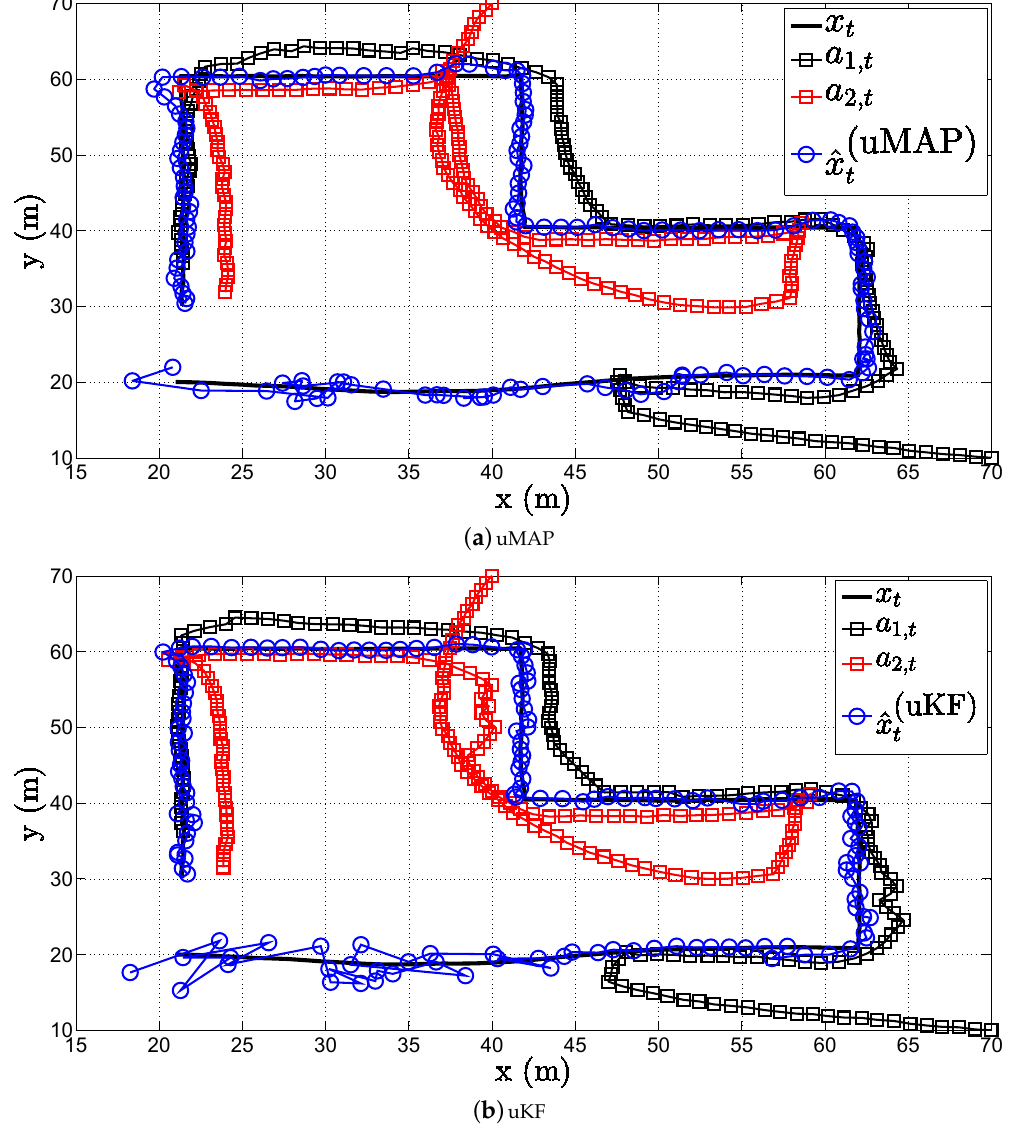
Figure 6. Illustration of the estimation process in the first scenario, when N = 2, (cid:107) v a (cid:107) = 1 m/s, = 9 dB, σ m = 4 π σ n rad, γ = 3, γ i ∼ U [ 2.7,3.3 ] , τ = 5 m, P 0 = − 10 dBm, q = 2.5 × 10 − 3 m 2 /s 3 180 i i